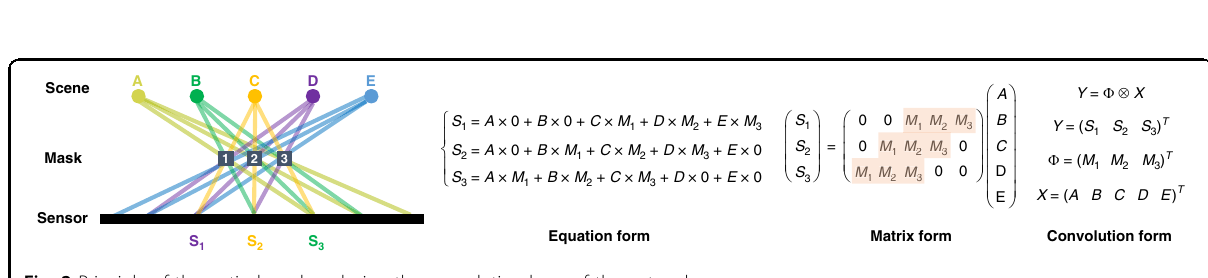
Fig. 2 Principle of the optical mask replacing the convolution layer of the